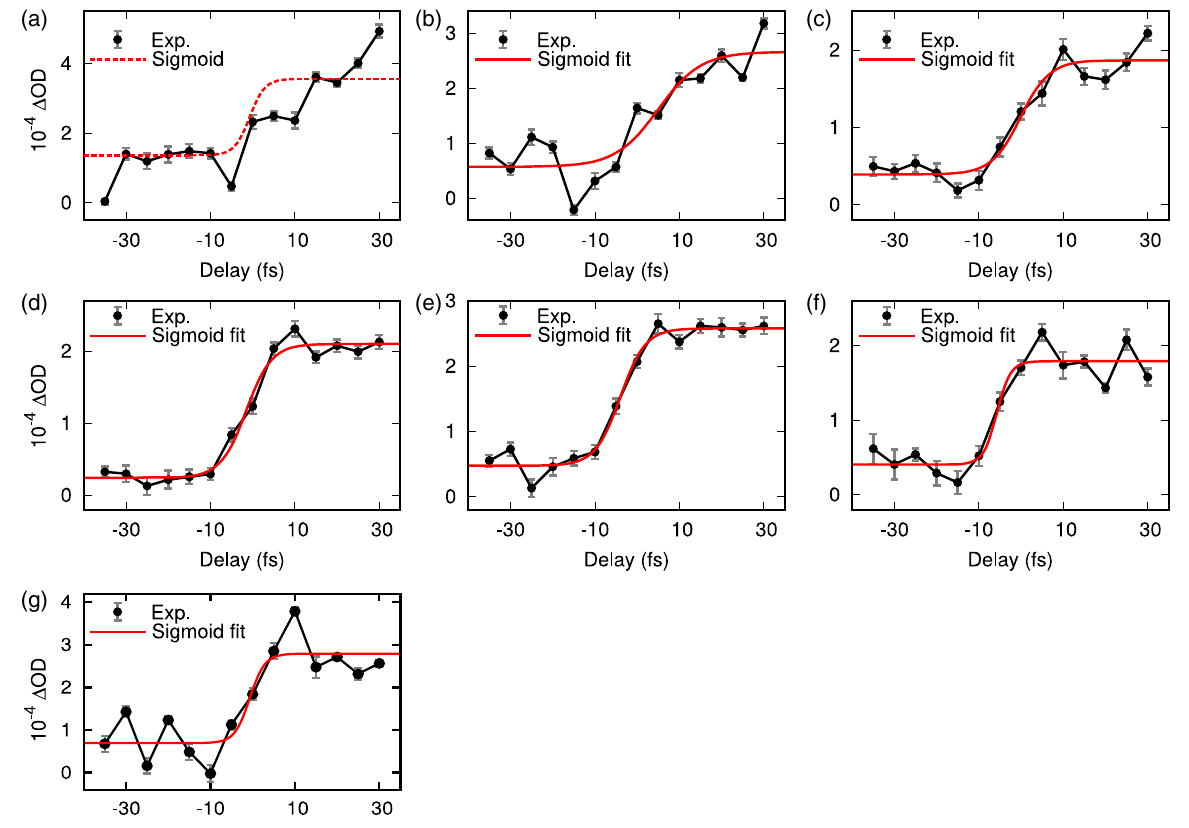
FIG. 9. Sigmoid fits (red lines) of the transient absorption scans for different energy regions on the fs timescale. The sigmoid in panel (a) is not a fit but a guide to the eye. The black points and the gray markers correspond to the measured change in optical density and to their standard error, respectively. The labels (b) to (g) correspond to different energy regions which are indicated in Table I. The energy region of panel (a) lies between 30 eV and 30.5 eV.